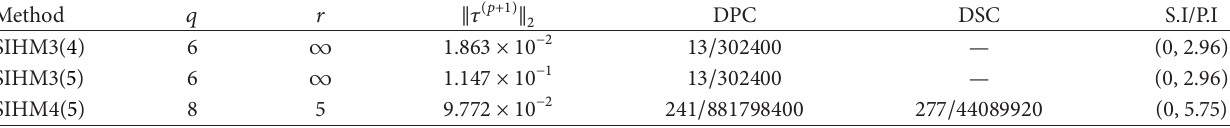
Table 1: Summary of the properties of the SIHM3(4), SIHM3(5), and SIHM4(5)